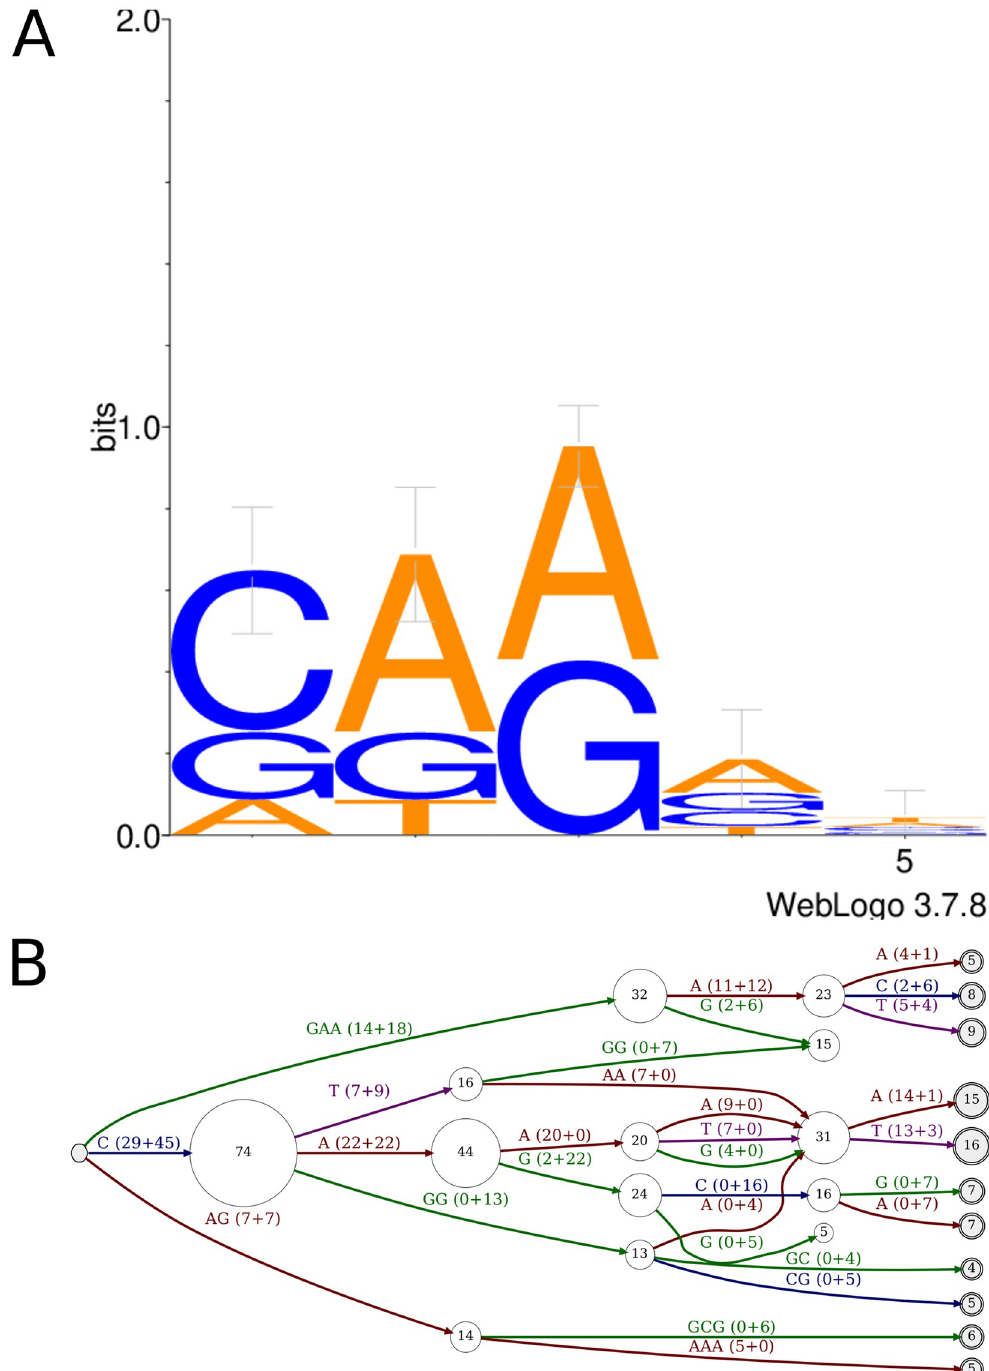
Fig 14. Logo and finite automaton representing 5-mers before deletion errors in non-homopolymeric region, in bacterial species. A : logo representation of 5-mers. B : automaton representation of 5-mers. Each node represents a position, and edges the letters in the k-mer. The initial node (on the very left side of the automaton, in grey) is the k-mer start. The final nodes (on the very right side of the automaton, in grey and double circled) are k-mer ends. For each edge, the weight ( i. e . number of k-mers supporting the edge) is detailed as the sum for low- and high-GC species. Node size is proportional to the total weight of input edges, displayed inside nodes. Only nodes having a total weight of at least 4 are displayed.